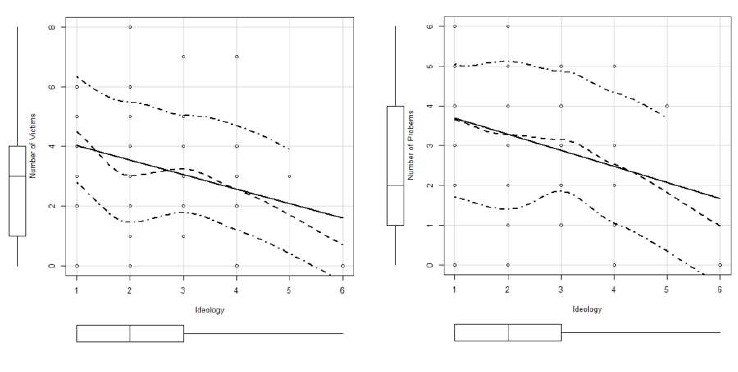
Figure 1: Relationship between Ideology and Narrative